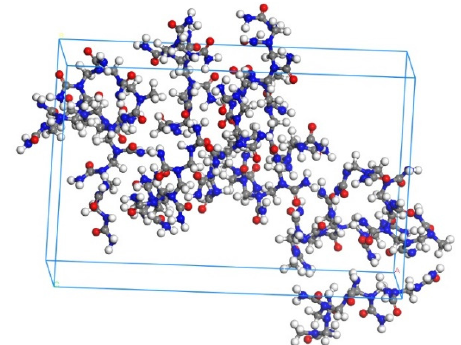
Figure 2. Molecular structure of UF (Color legend: hydrogen H (white); oxygen O (red); nitrogen N (blue) carbon C (grey)).